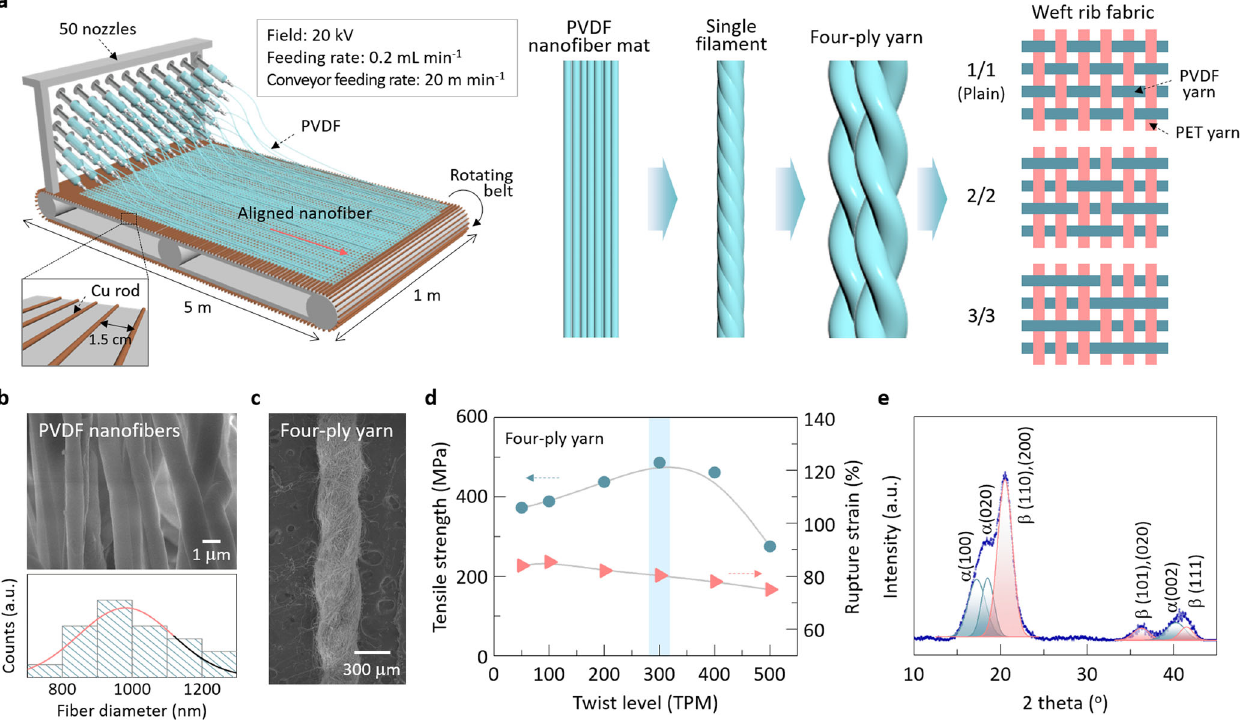
Fig. 1 Preparation of PVDF yarns and versatile woven fabrics. a Schematic of the 50 nozzle electrospinning process for producing an aligned PVDF nano fi ber mat, wherein the Cu rods are positioned in parallel on the conveyor belt, with the steps for preparing three woven structures from four-ply yarns made from a single fi lament. b SEM image of the aligned as-prepared PVDF fi bers with the fi ber diameter distribution. c SEM image of a four-play yarn. d Tensile strength and rupture strain of the four-ply yarn as a function of the twist level. e XRD pattern of the four-ply yarn, indicating the presence of α - and β